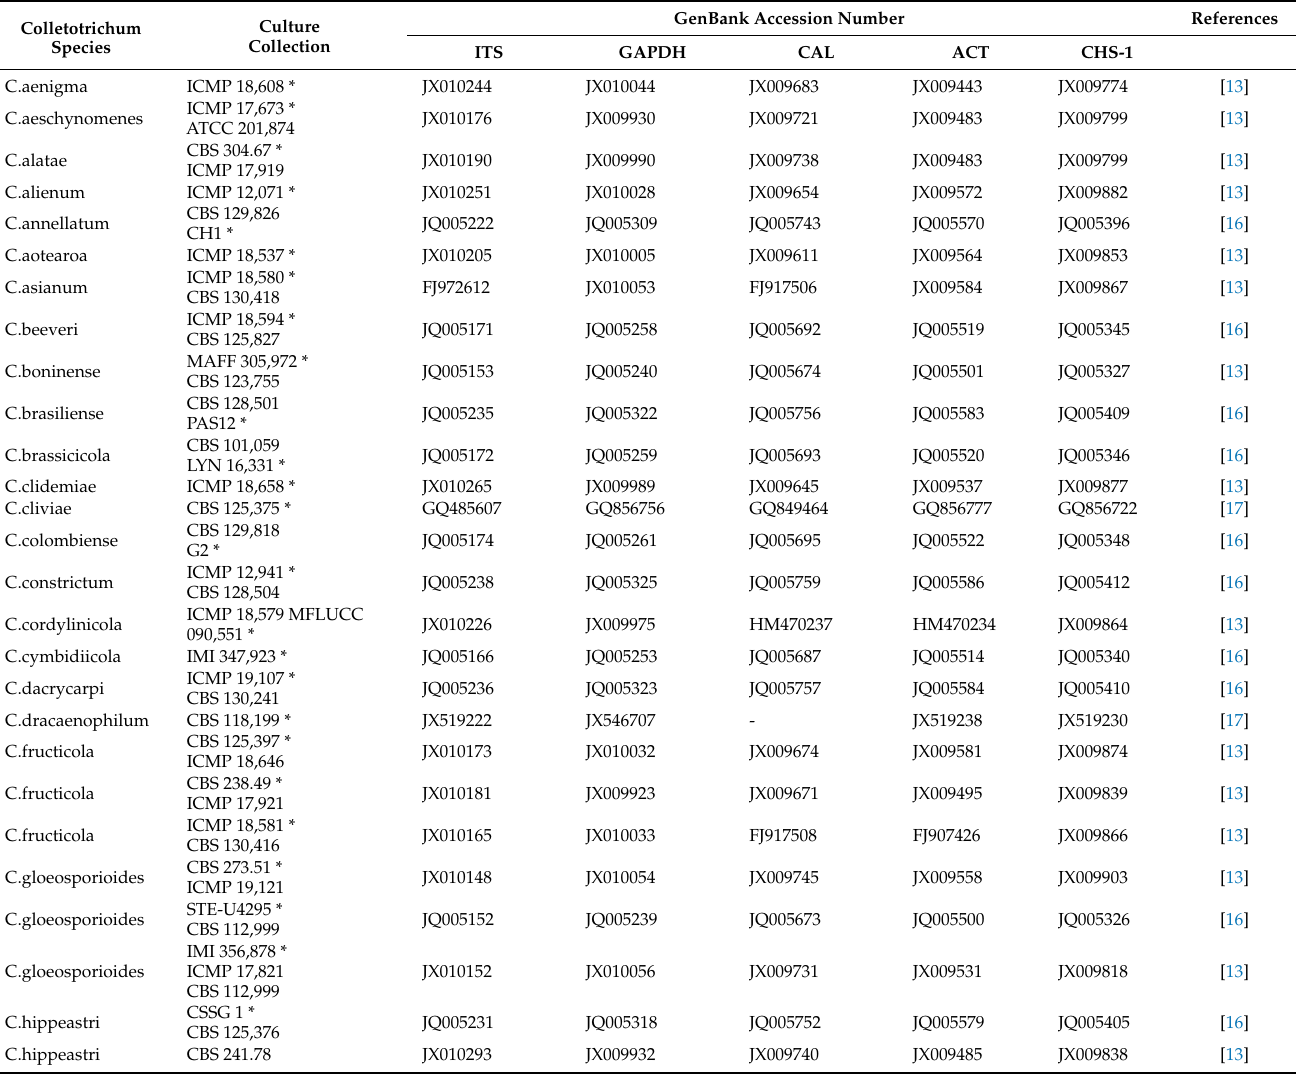
Table A1. GenBank accession numbers of the accepted Colletotrichum